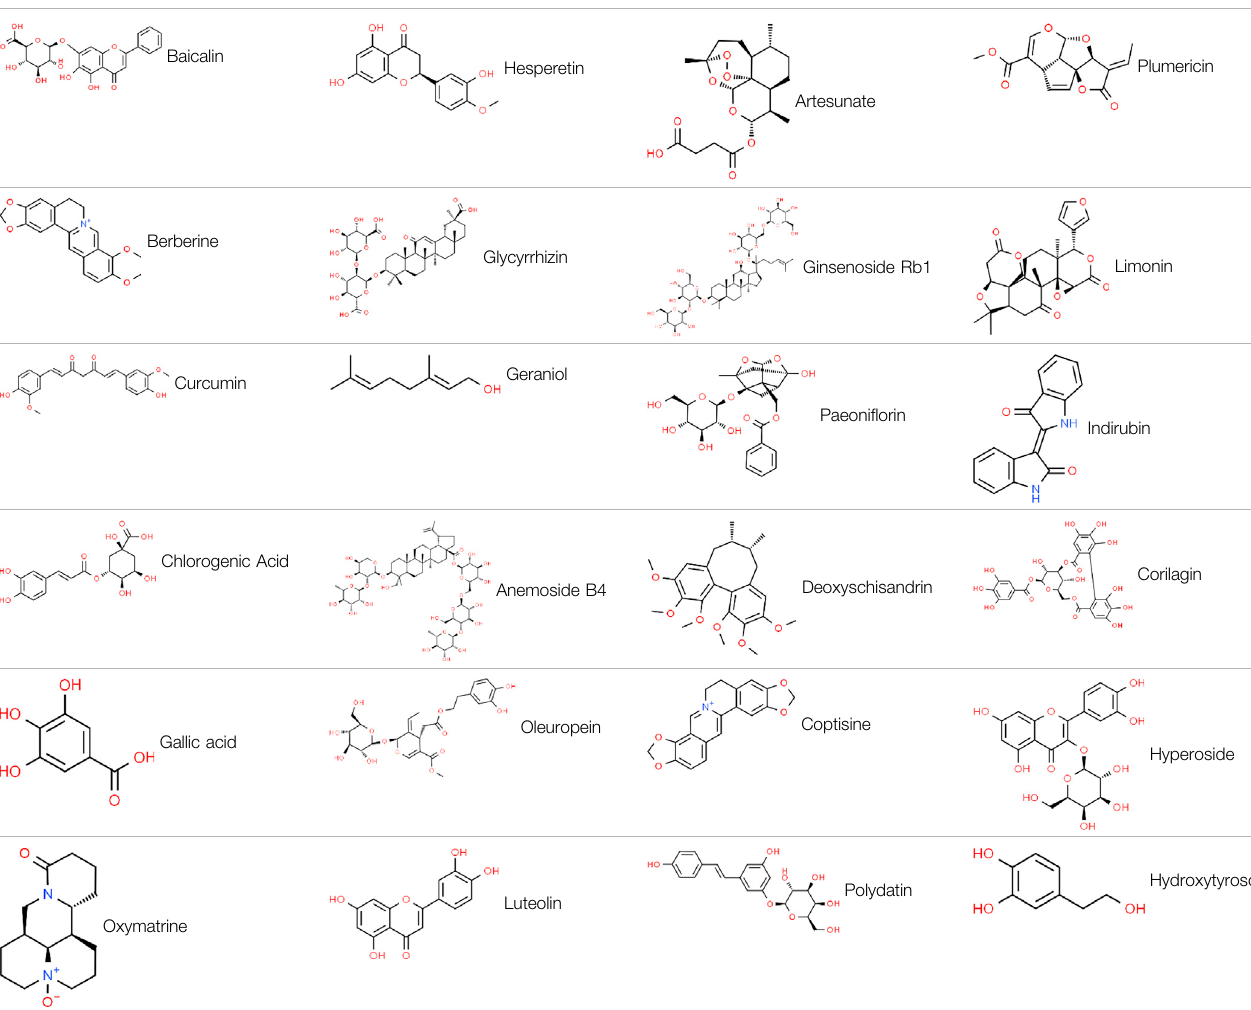
TABLE 3 | Chemical structures of natural